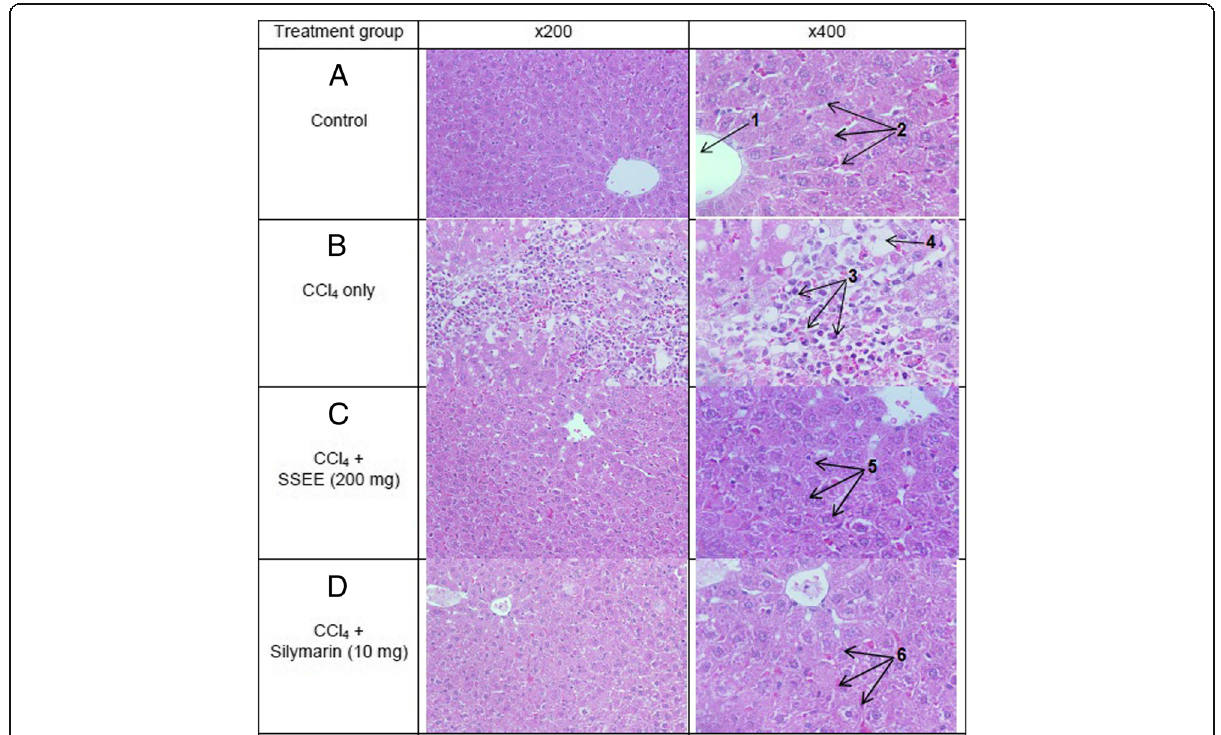
Fig. 2 Histopathology of experimental rat liver. Histograms showing ( a ) healthy tissues with normal central vein and hepatocytes; ( b ) CCl 4 -injured tissue with necrosis and fatty degenerative changes; ( c ) tissue with normal hepatocytes and central vein with full recovery after CCl 4 plus SSEE (200mg.kg.bw) treatment; and ( d ) tissue with normal hepatocytes and fully recovered central vein after CCl 4 plus silymarin (10mg.kg.bw) treatment. 1. Central vein; 2. Normal hepatocytes cord; 3. Focal necrosis; 4. Vacuoles of fatty degeneration; 5. Normal hepatic tissue; 5. Normal hepatic